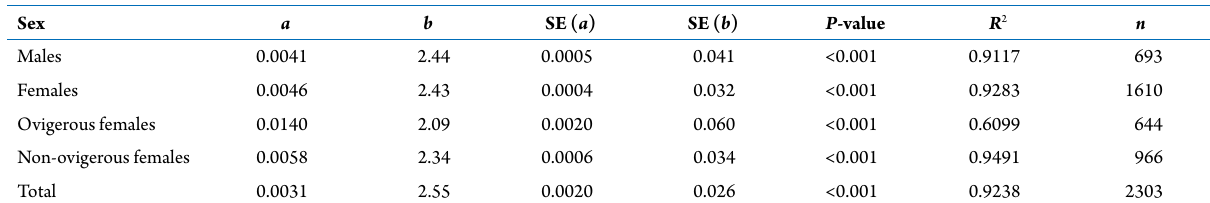
Table 4. Parameters of CL–WW relationship ( W = a CL b ) for males, females and all shrimps of Plesionika edwardsii caught during the period 1999-2000. a : intercept, b : regression coefficient (allometric coefficient), SE: standard error, P -value: likelihood ratio test p value; R 2 : determination coefficient; n : number of individuals.